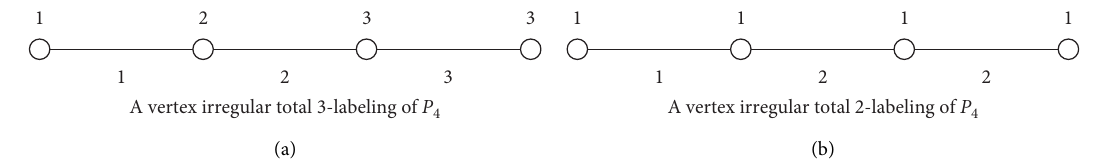
Figure 1: A vertex irregular total k -labeling of P